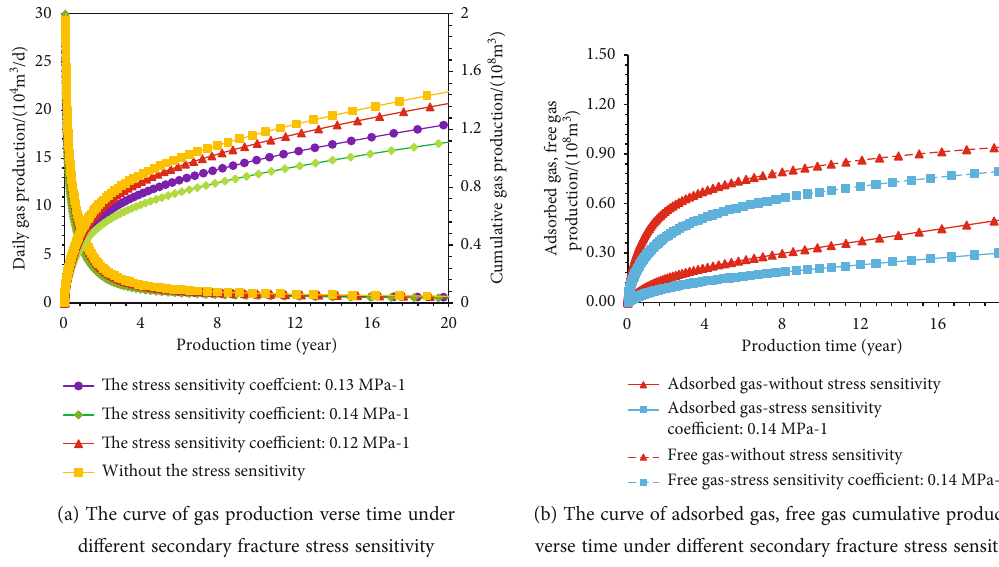
Figure 11: E ff ect of stress sensitivity of secondary fractures on shale gas